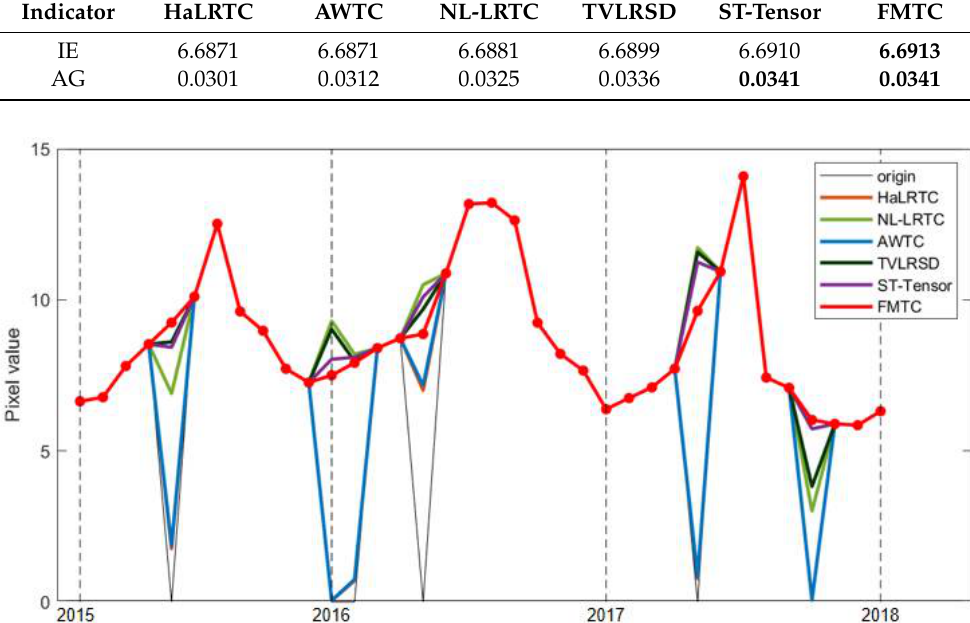
Figure 21. The time-series curves of six algorithms applied to one pixel from 2015 to 2017.